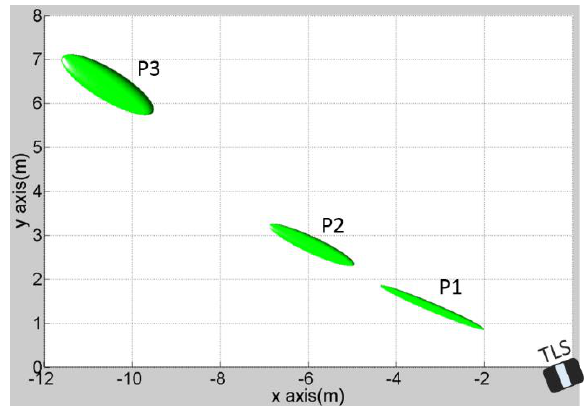
Figure 12. Error ellipsoids at plan view associated with P1,P2 and P3. Location of TLS is depicted at lower right